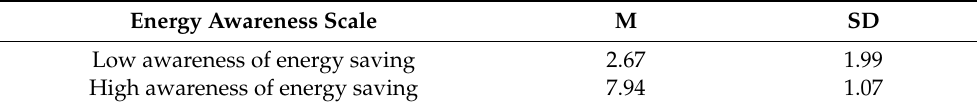
Table 1. Outcomes of awareness of sustainable energy consumption among young people with ASD (in sten